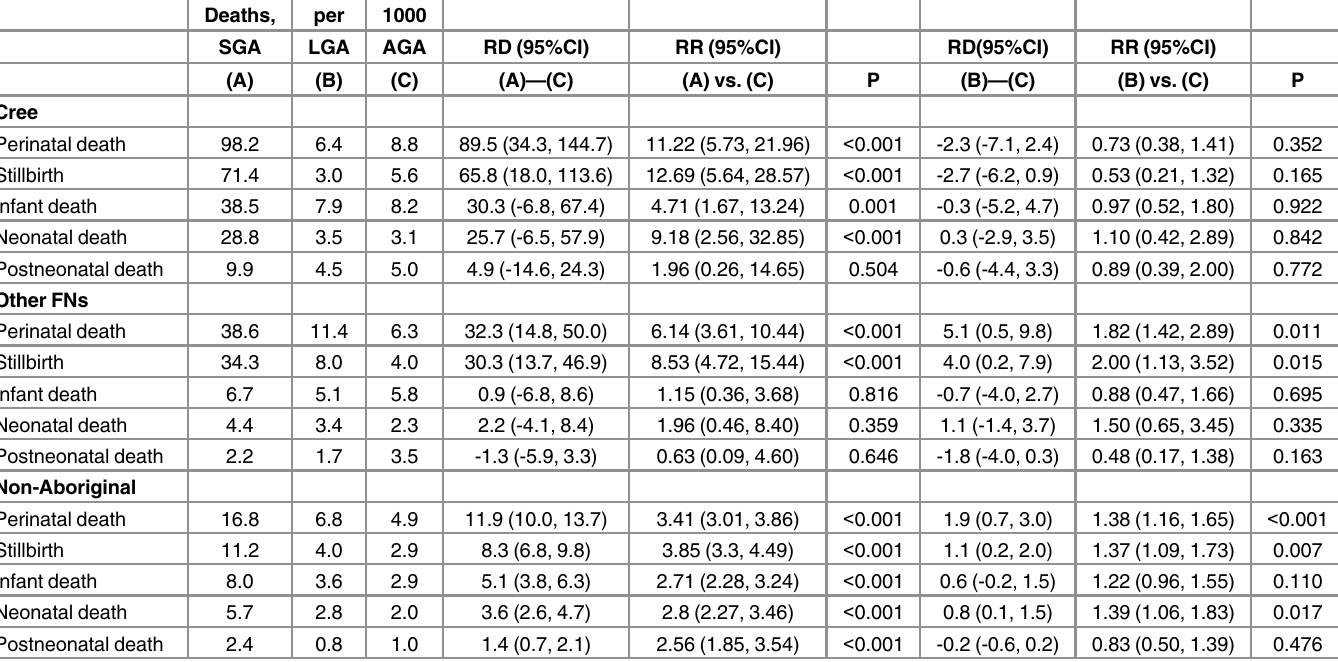
Table 5. Perinatal and infant mortality rates comparing SGA or LGA to AGA births within Cree, other First Nations and non-Aboriginal communi- ties in Quebec 1996 – 2010.